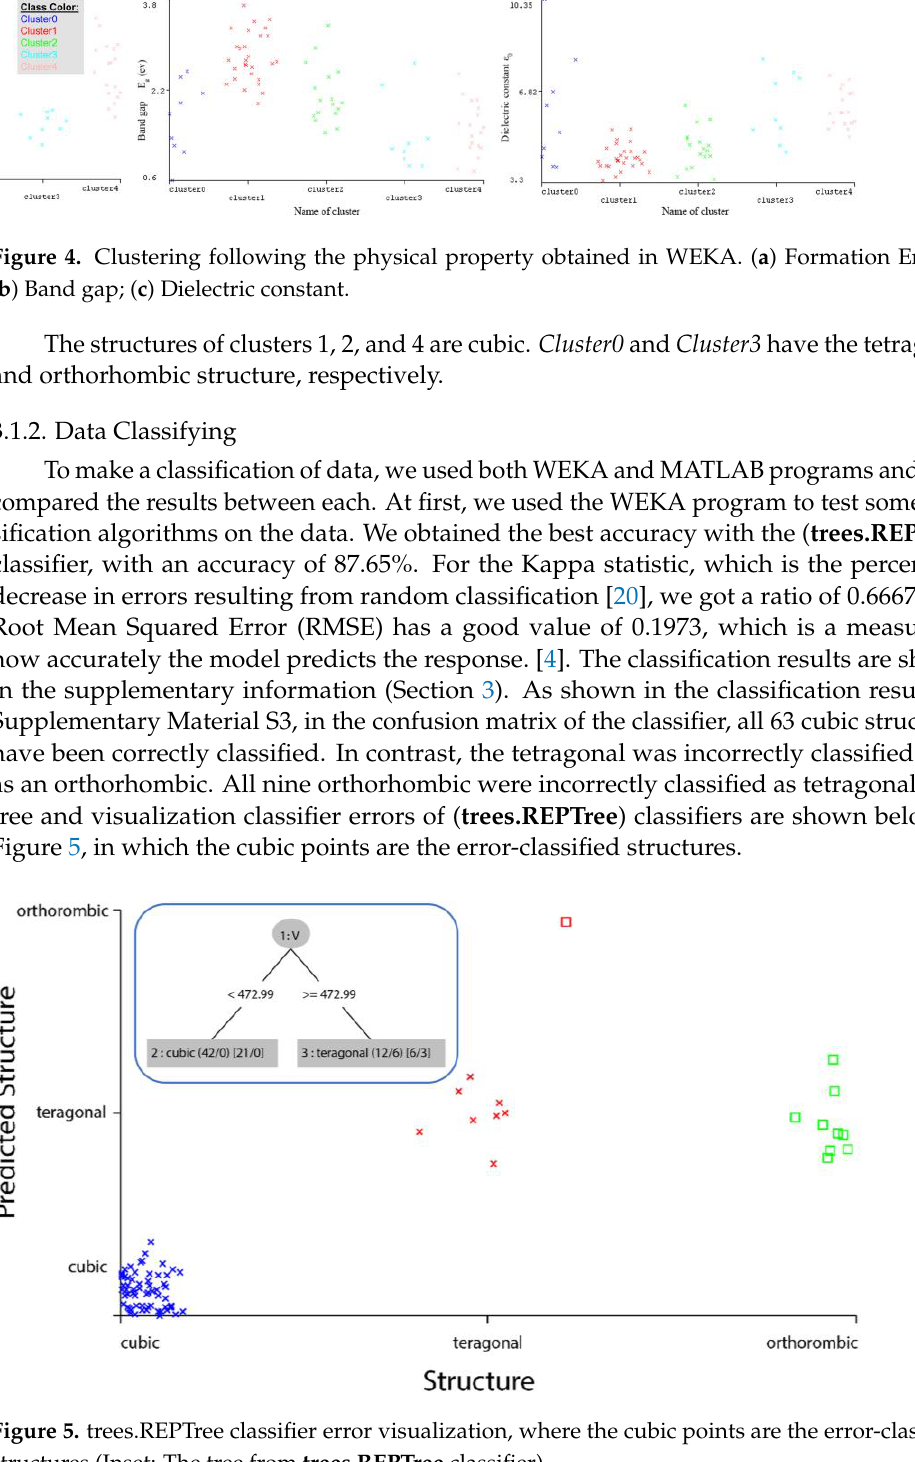
Figure 6. The classification error representation of the tree classifier, where x points represent the incorrect classification of data. ( a ) Formation Energy; ( b ) Band gap; ( c ) Dielectric constant.